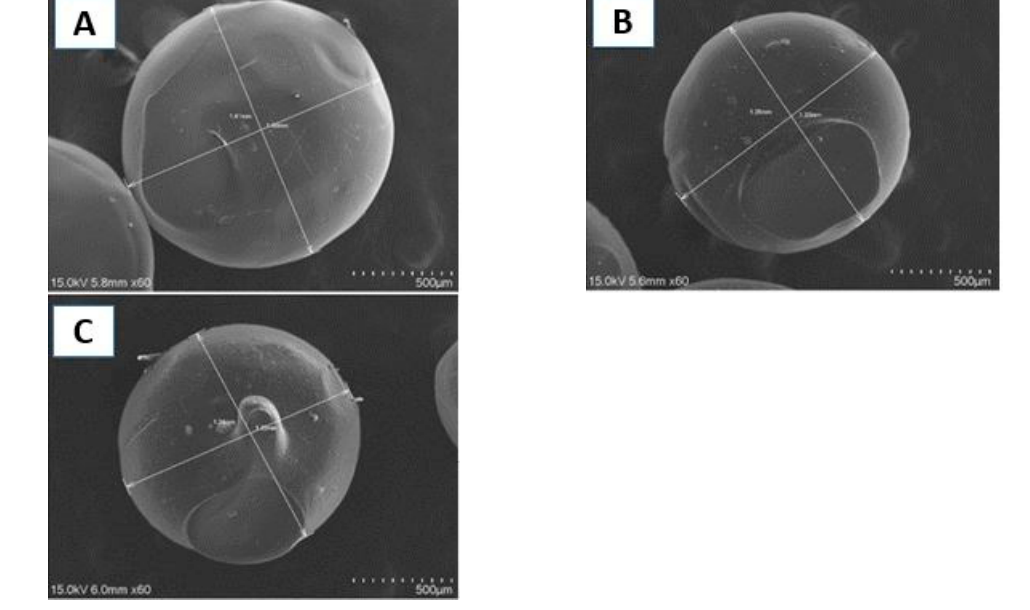
Figure 1. SEM micrographs. Chitosan microcapsules ( A ); Chitosan microcapsules + nanomagnetite ( B ) and Chitosan microcapsules + nanomagnetite + drug ( C ). Table 2. Average microcapsules size.